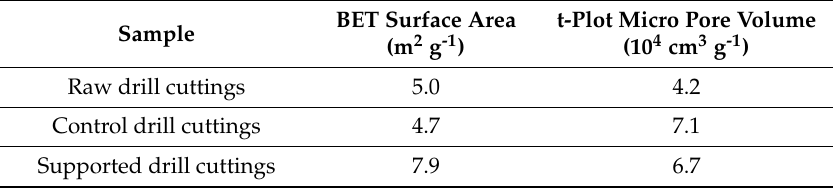
Table 2. Brunauer–Emmett–Teller (BET) surface area and pore volume measurement for the various drill